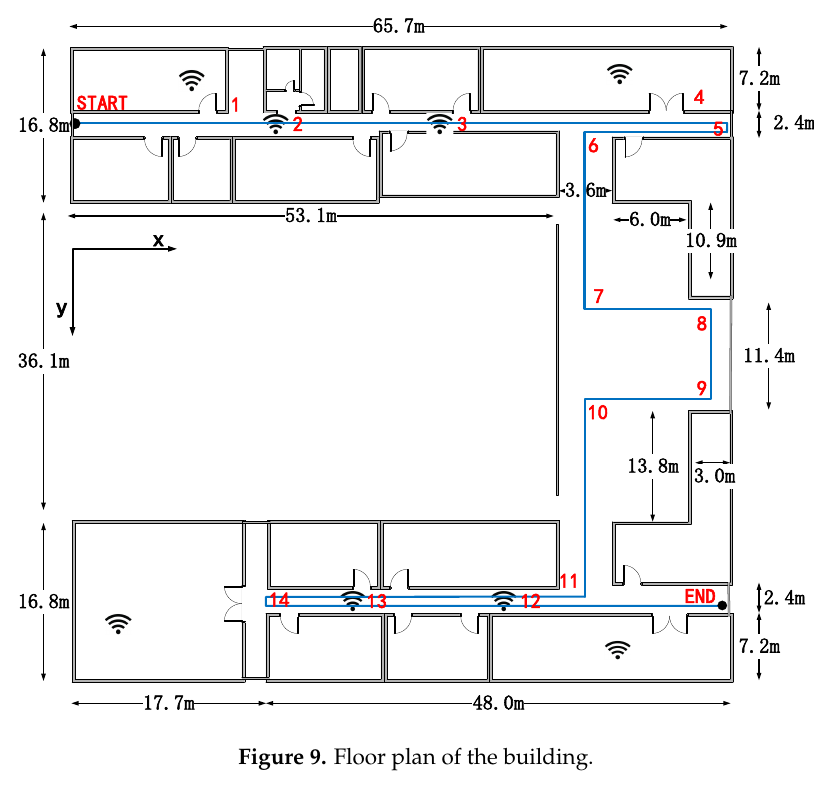
Figure 9. Floor plan of the building.